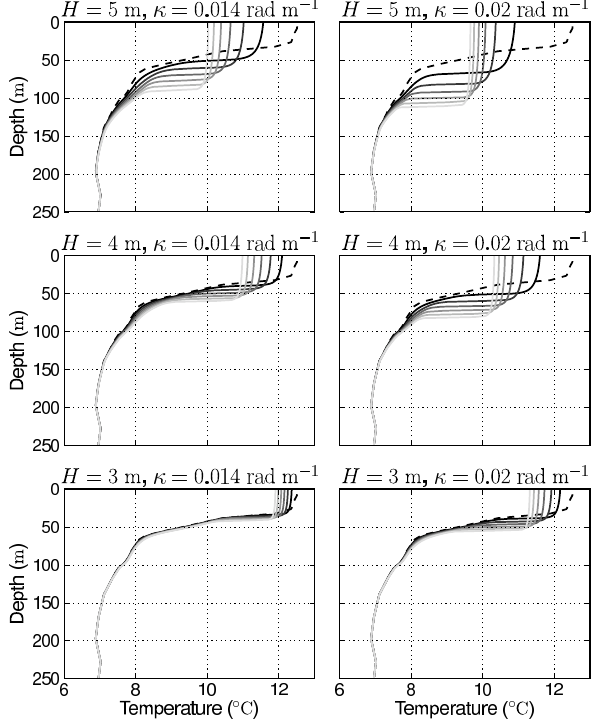
Fig. 1. Mixing in GOTM due to non-breaking wave-induced turbu- lence using the parameterisation for wave dissipation from Babanin (2011). The wave heights and wave numbers correspond to typical values from the data of Ardhuin et al. (2009). The dashed line is the initial temperature profile, and the solid lines for the profile at two-hour intervals, with lighter lines indicating more time having